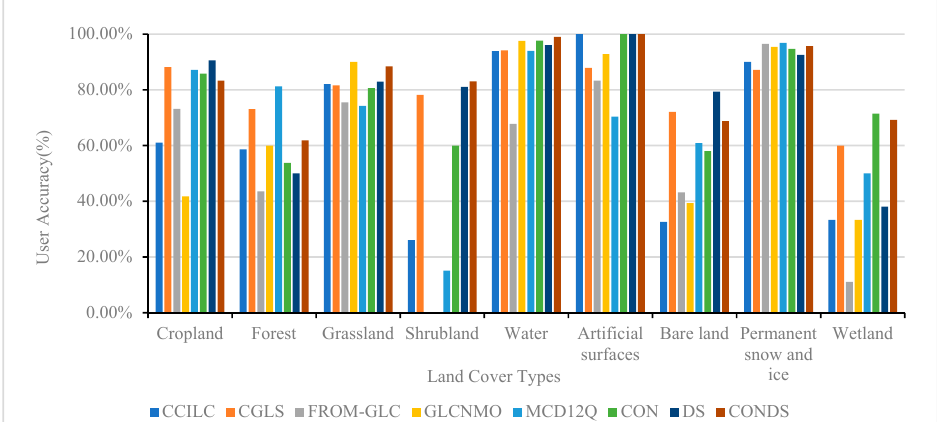
Figure 7. User accuracy of landcover products and fusion results.